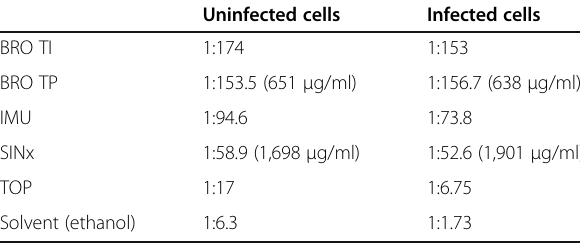
Table 1 Cytotoxicity of herbal extracts in Vero cells. Half- maximal cytotoxic concentrations (CC 50 ) as determined by MTT assay Uninfected cells Infected